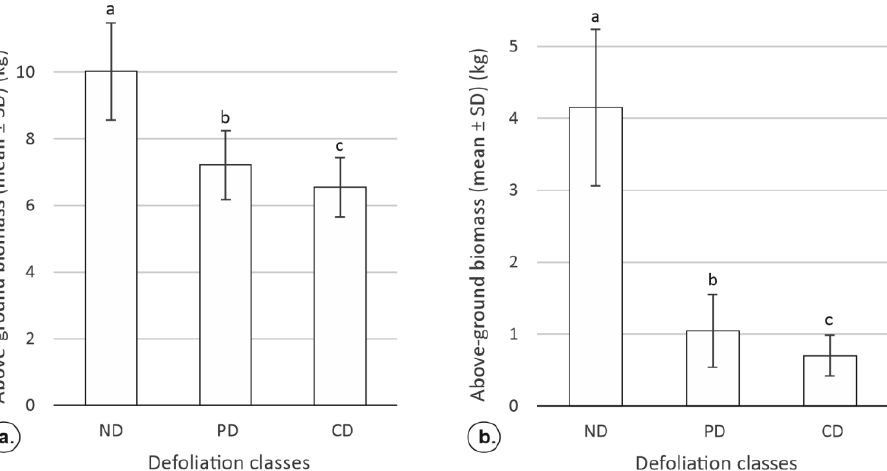
Figure 6. Aboveground biomass of poplar trees for the period 2014 – 2017 ( a ) and in 2017 ( b ). ND — non-defoliated trees; PD — partially defoliated trees; CD — completely defoliated trees. Bars with dif- ferent lowercase letters indicate significant differences according to Tukey ’ s multiple comparison test ( p < 0.05).